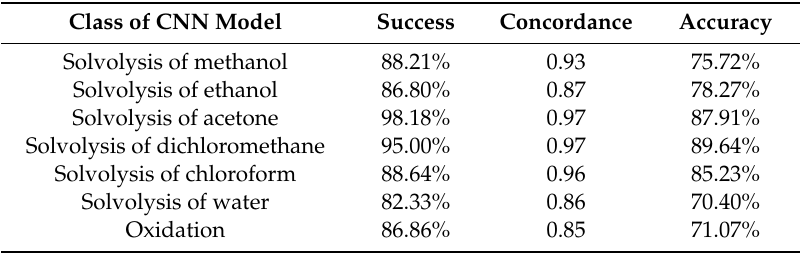
Table 3. Performance of the used CNN models on validation data